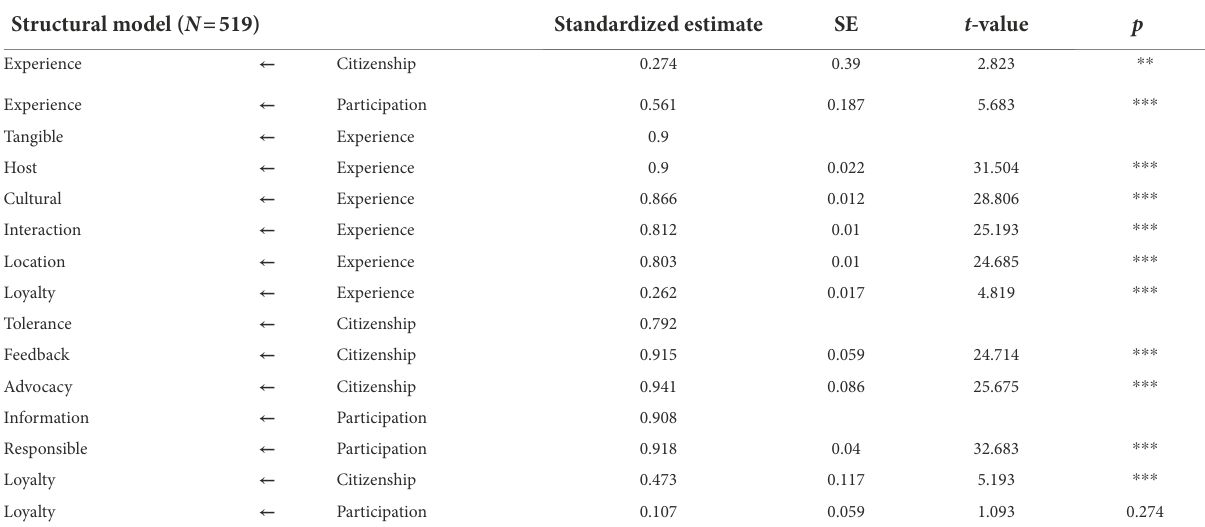
TABLE 4 Path coefficients in structural model. Structural model ( N = 519)